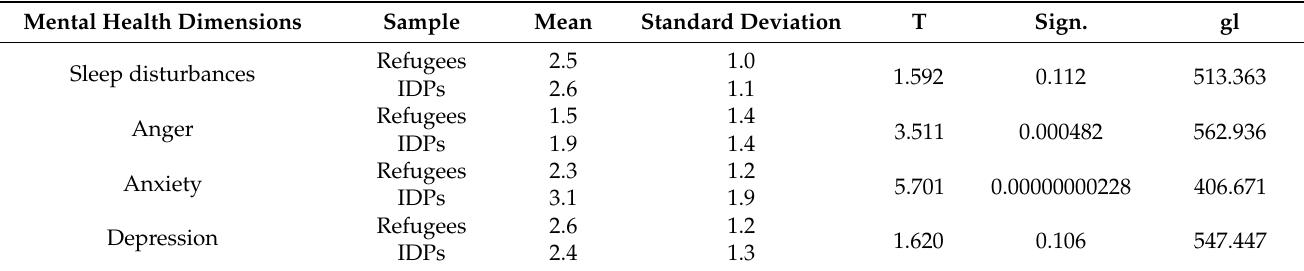
Table 5. Mental health dimensions: t -test for independent